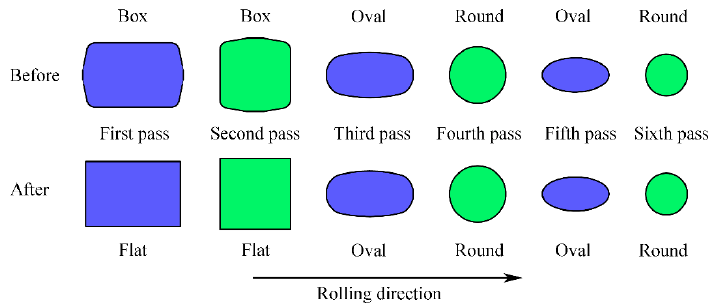
Figure 9. Comparison of previously and newly designed six-pass rolling sequence.